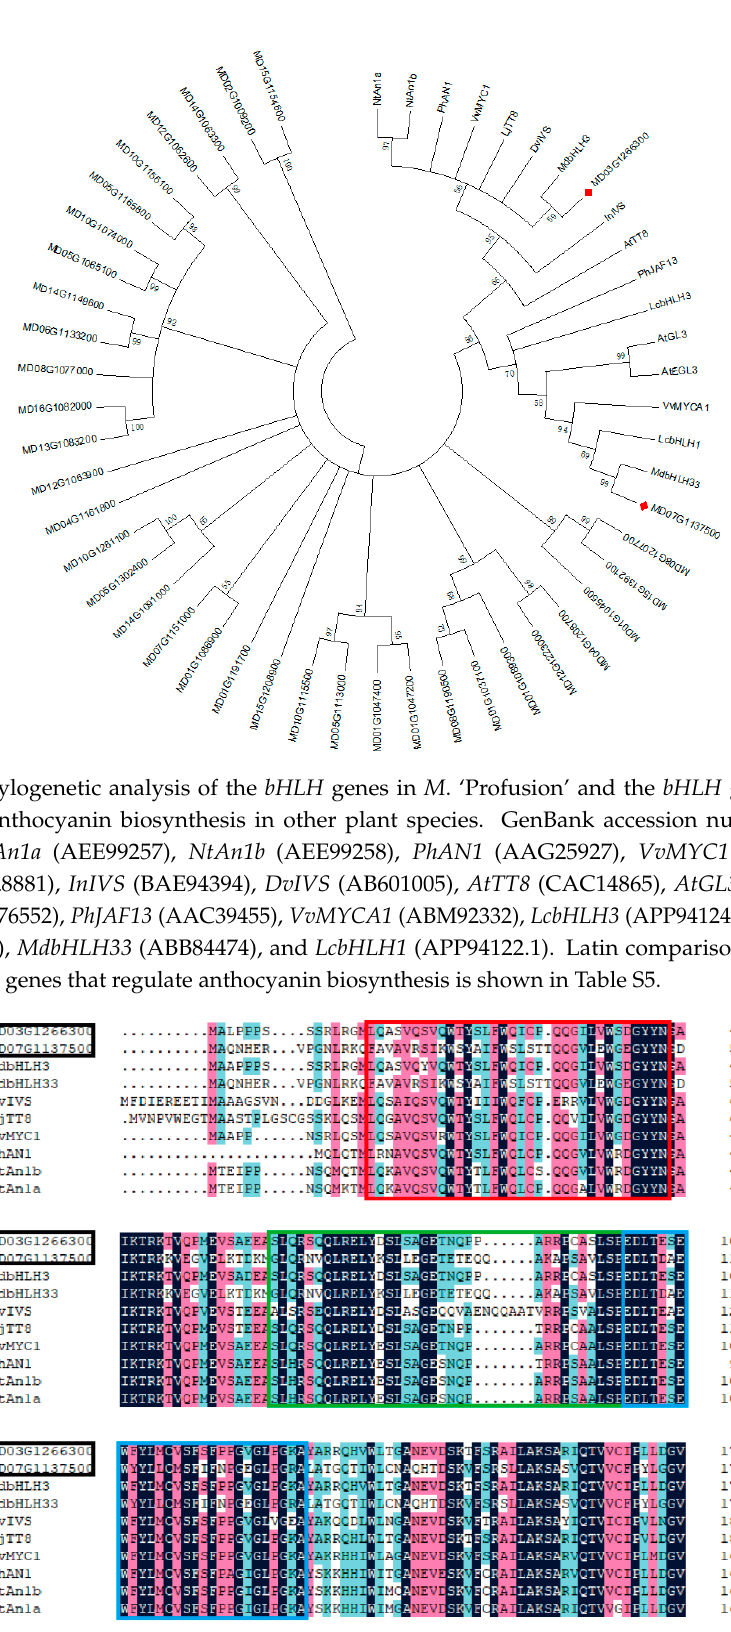
Figure 9. Alignment of the protein sequences of MD03G126300 and MD07G1137500 with bHLH genes known to promote anthocyanin biosynthesis in other plant species. The red, green, and blue boxes represent boxes 11, 18, and 13, respectively.